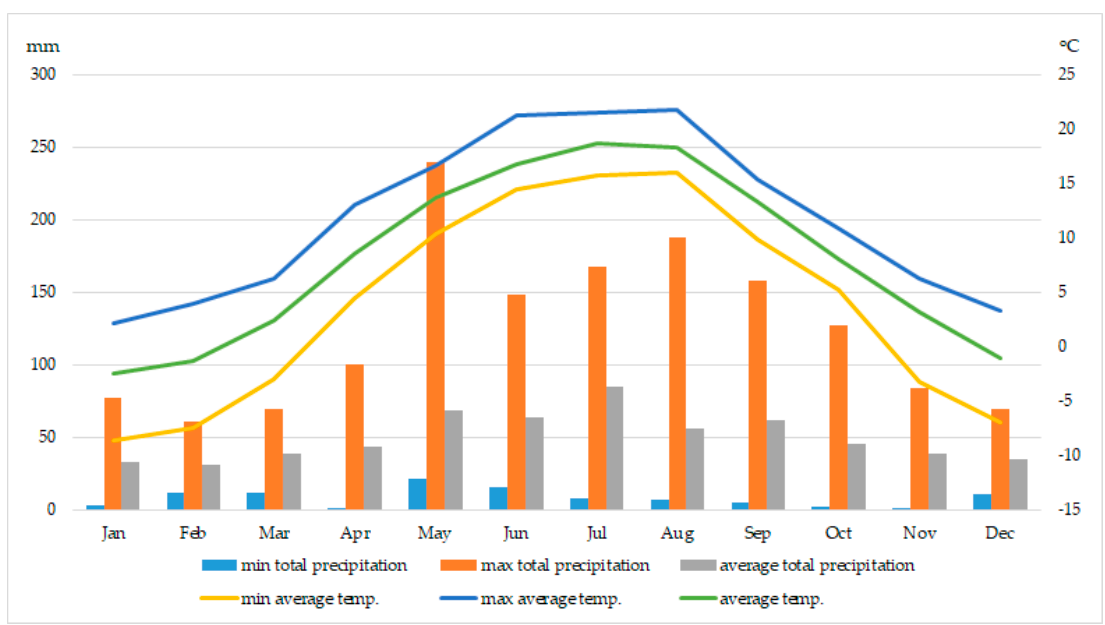
Figure 2. The mean monthly temperature and precipitation sums for the period 1990–2019, and the highest and lowest monthly means measured in Lubartów in the same period.